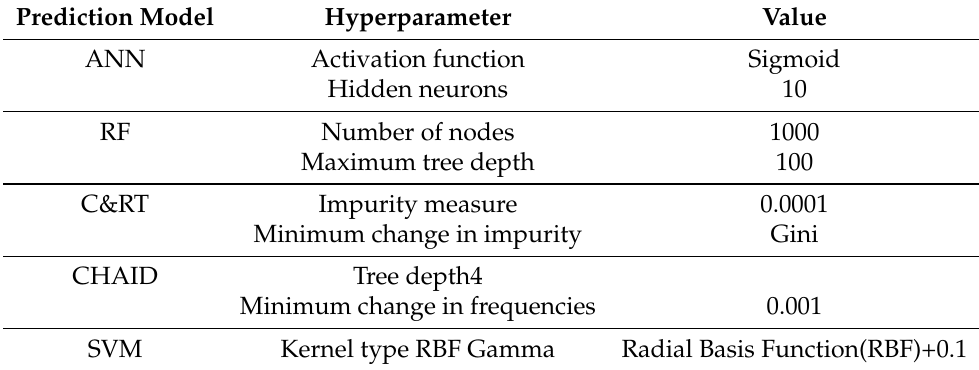
Table 2. The hyperparameters of six PV power output prediction